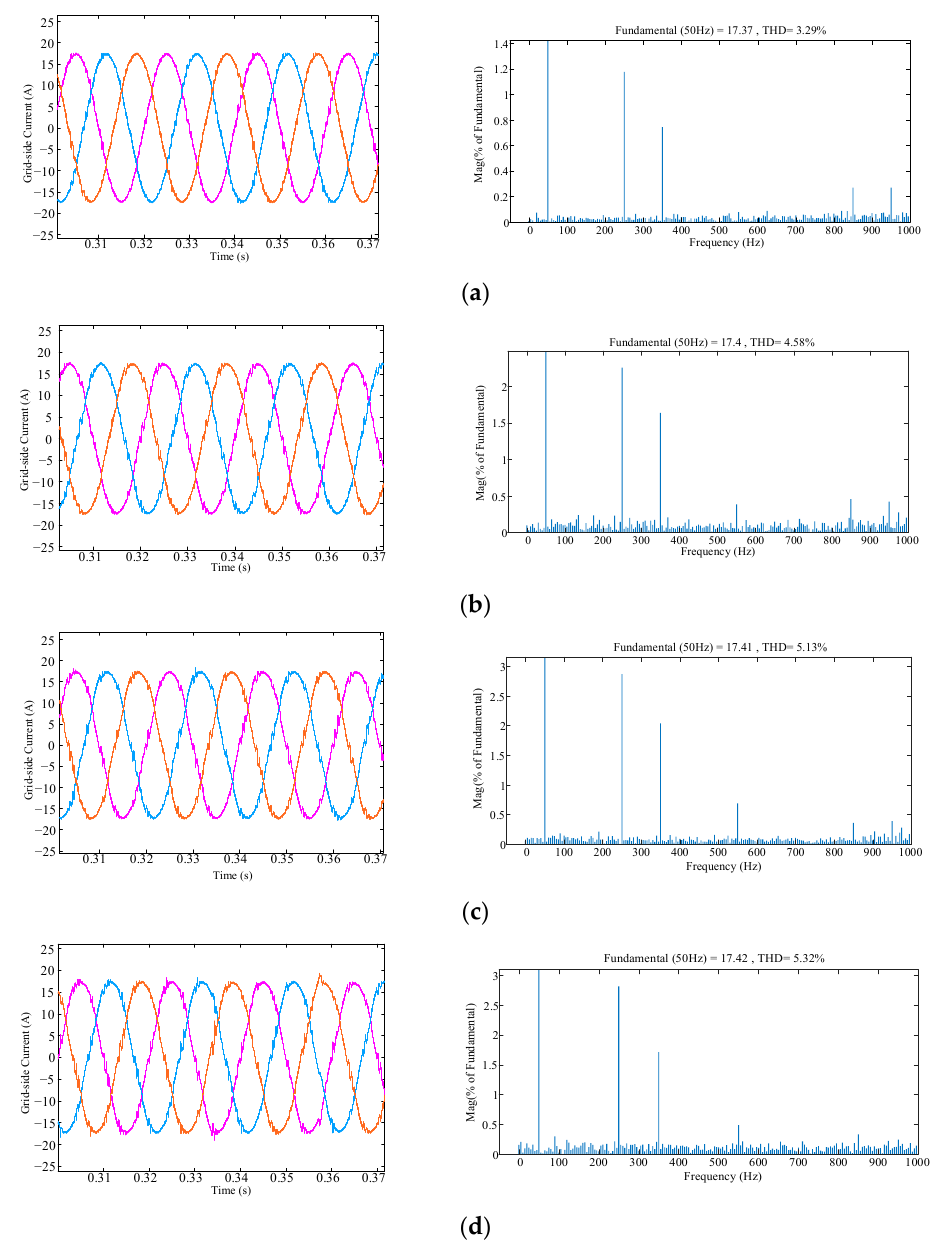
Figure 11. Simulation results of the grid current with different overlap times at 10 kHz switching frequency. ( a ) t ov = 0 μ s. ( b ) t ov = 3 μ s. ( c ) t ov = 5 μ s. ( d ) t ov = 7 μ s.